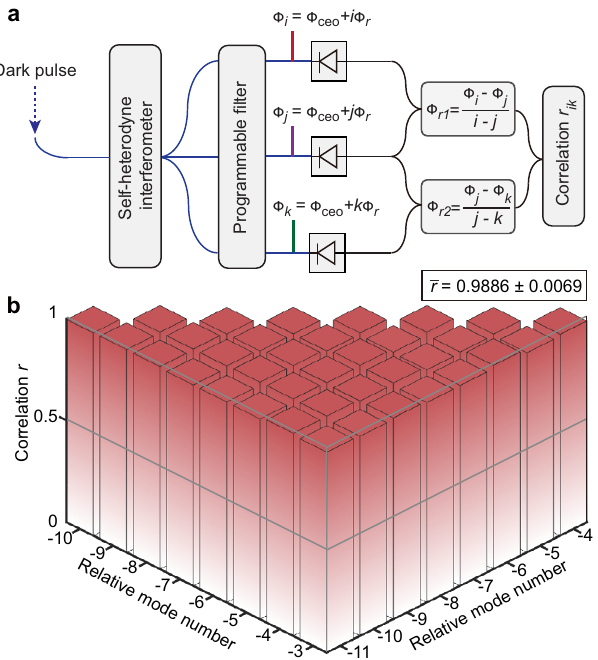
Fig. 4 | Phase correlation of comb lines. a Schematic illustration of phase corre- lation measurement. b Correlation map of − 3rd to − 11th comb